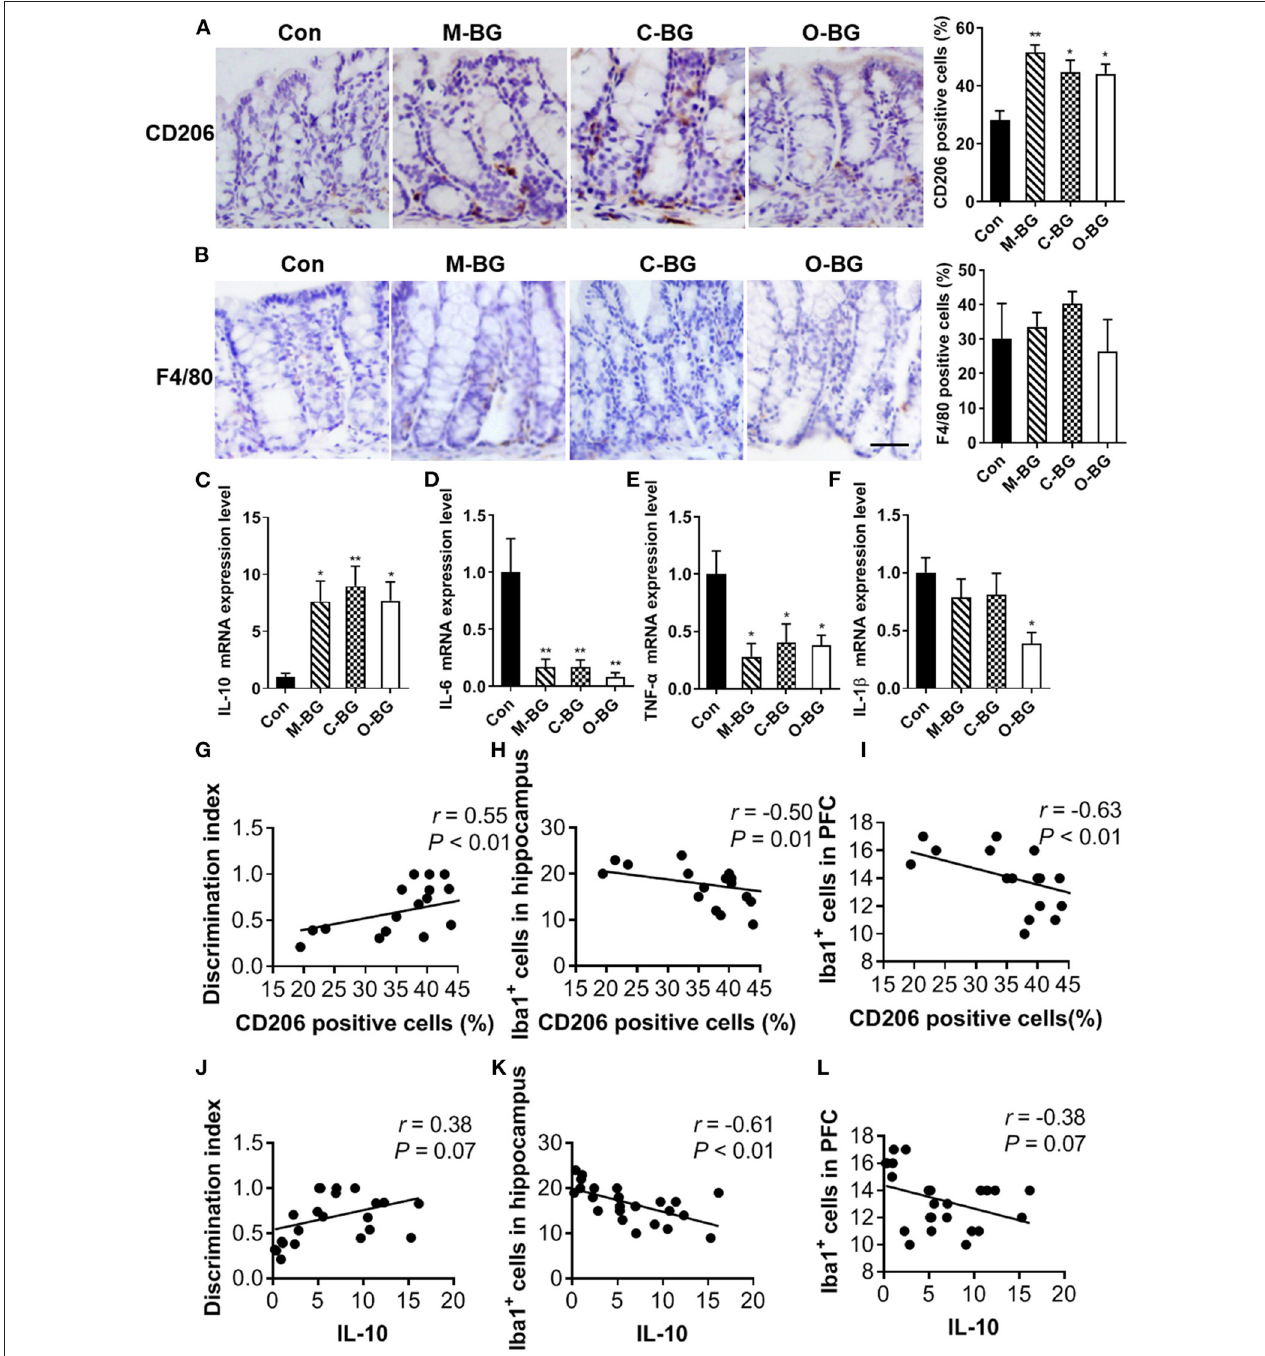
FIGURE 3 | β -glucans promoted macrophage M2 polarization in the colon. (A) Immunohistochemical staining and quantification of colonic CD206-positive cells. (B) Immunohistochemical staining and quantification of colonic F4/80-positive cells. (C–F) mRNA expression levels of IL-10 (C) , IL-6 (D) , TNF- α (E) , IL-1 β (F) in the colon of mice. (G–I) Pearson’s correlation analysis between CD206 positive cells in colon and discrimination index (G) , Iba1 + cells in the hippocampus (H) and in the PFC (I) . If P < 0.05 for significant correlations, R is noted. (J–L) Pearson’s correlation analysis between IL-10 mRNA expression in colon and discrimination index (J) , Iba1 + cells in the hippocampus (K) and Iba1 + cells in the PFC (L) . If P < 0.05 for significant correlations, R is noted. All n = 6. Data were presented as mean ± SEM. * P < 0.05 vs. Control, ** P < 0.01 vs. Control, *** P < 0.001 vs. Control. Scale bar: 80 µ m.